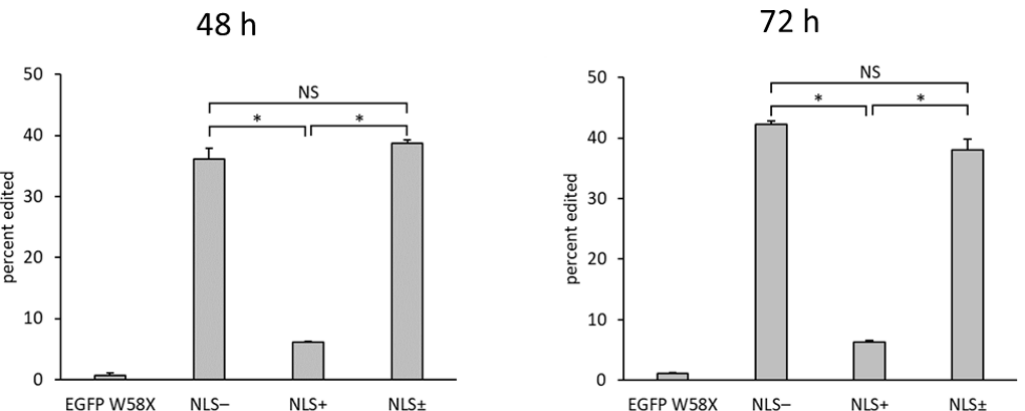
Figure 3. Bar graphs showing the editing efficiency (%) at 48 h (left) or 72 h (right) after transfection, calculated from the sequencing results using the peak height ratio method. Error bars represent standard error ( n = 3). Asterisks indicate statistically significant differences ( p < 0.05). NS (not significant) signifies no statistically significant difference.